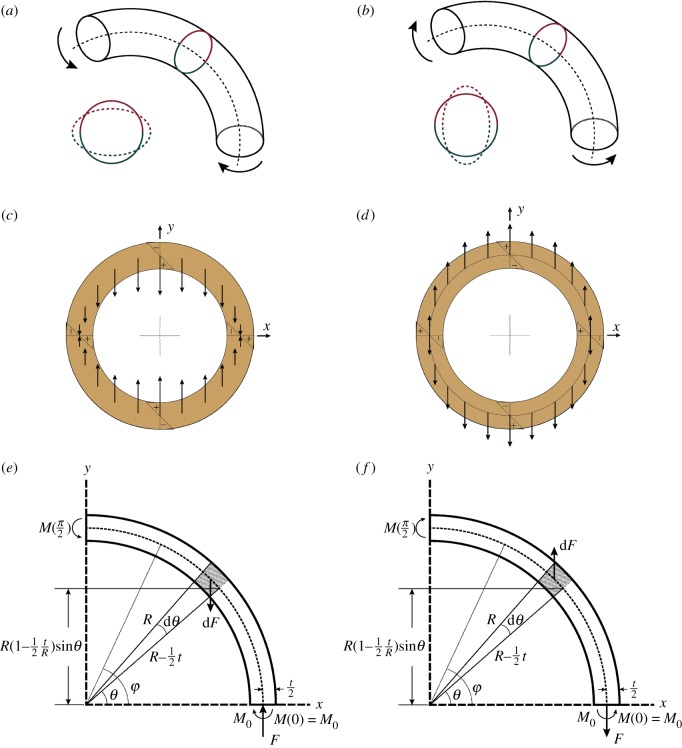
Analysis of cross-sectional flattening of a curved circular hollow trunk for curvature-increasing (a,c,e) and for curvature-decreasing (b,d,f). (c,d) Inward and outward force distribution in a transverse section. (e,f) Free-body diagram of one quarter of the transverse section for calculating the bending moment M(φ) exerted on axial sections with an angular position φ. θ, angular position of the transverse force dF; M0, statically indeterminate bending moment at φ = 0. The direction of dF determines the direction of cross-sectional flattening. Note that dF is a body force per unit axial length (unit: N m−1), not a shear force. F is the internal normal force per unit length acting on the axial-radial plane at φ = 0.